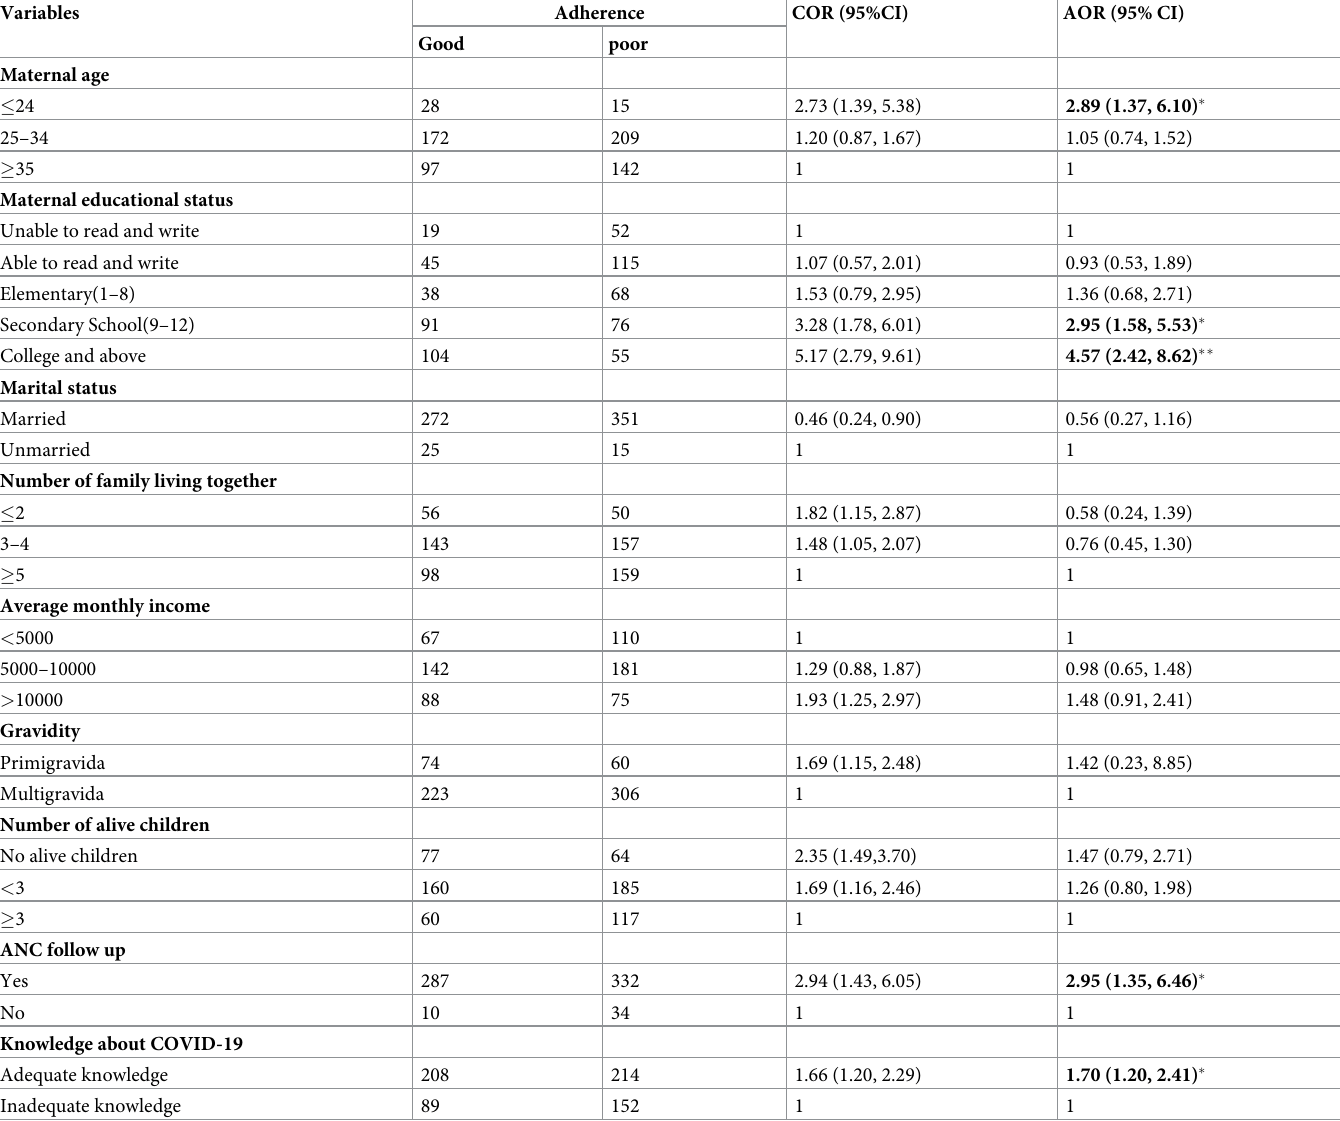
Table 4. Bivariable and multivariable logistic regression analysis of factors affecting adherence to COVID 19 preventive practice among pregnant women in Gon- dar city, northwest Ethiopia, 2021 (n = 663).